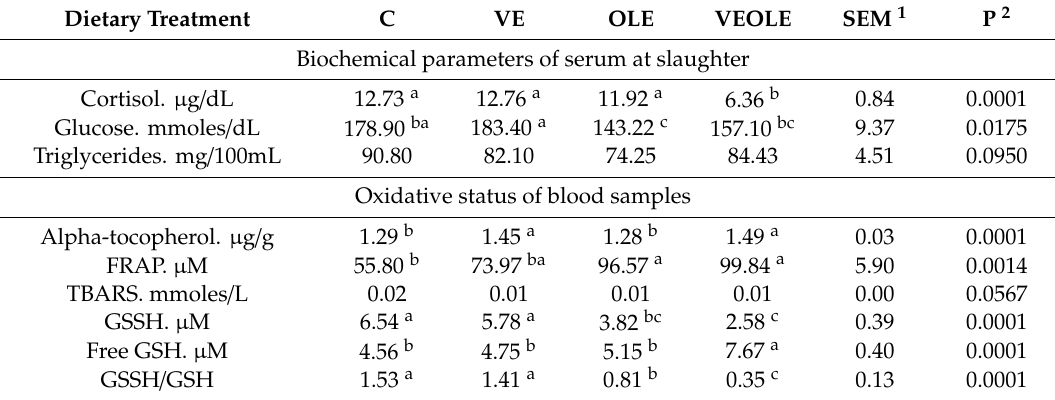
Table 1. Biochemical parameters and oxidative status of blood samples at slaughter from pigs fed the experimental diets (C, control; VE, vitamin E + Se; OLE, oleuropein extract; VEOLE, vitamin E + Se + oleuropein extract). Dietary Treatment